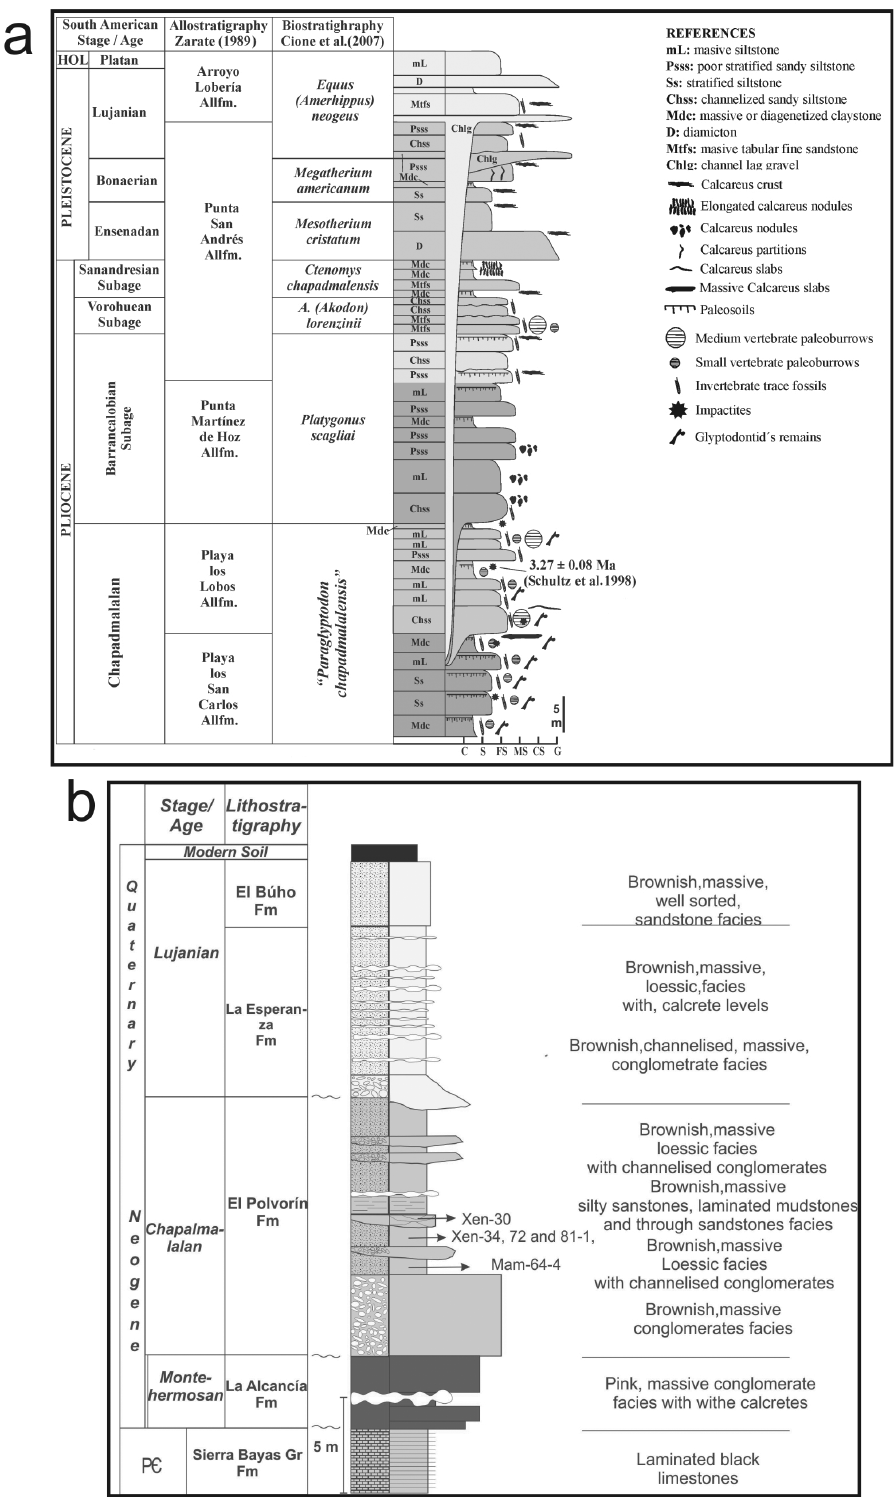
Figure 2 - Lithostratigraphic pro fi le of Chapadmalal (a) and El Polvorín (b) formations showing the fossiliferous